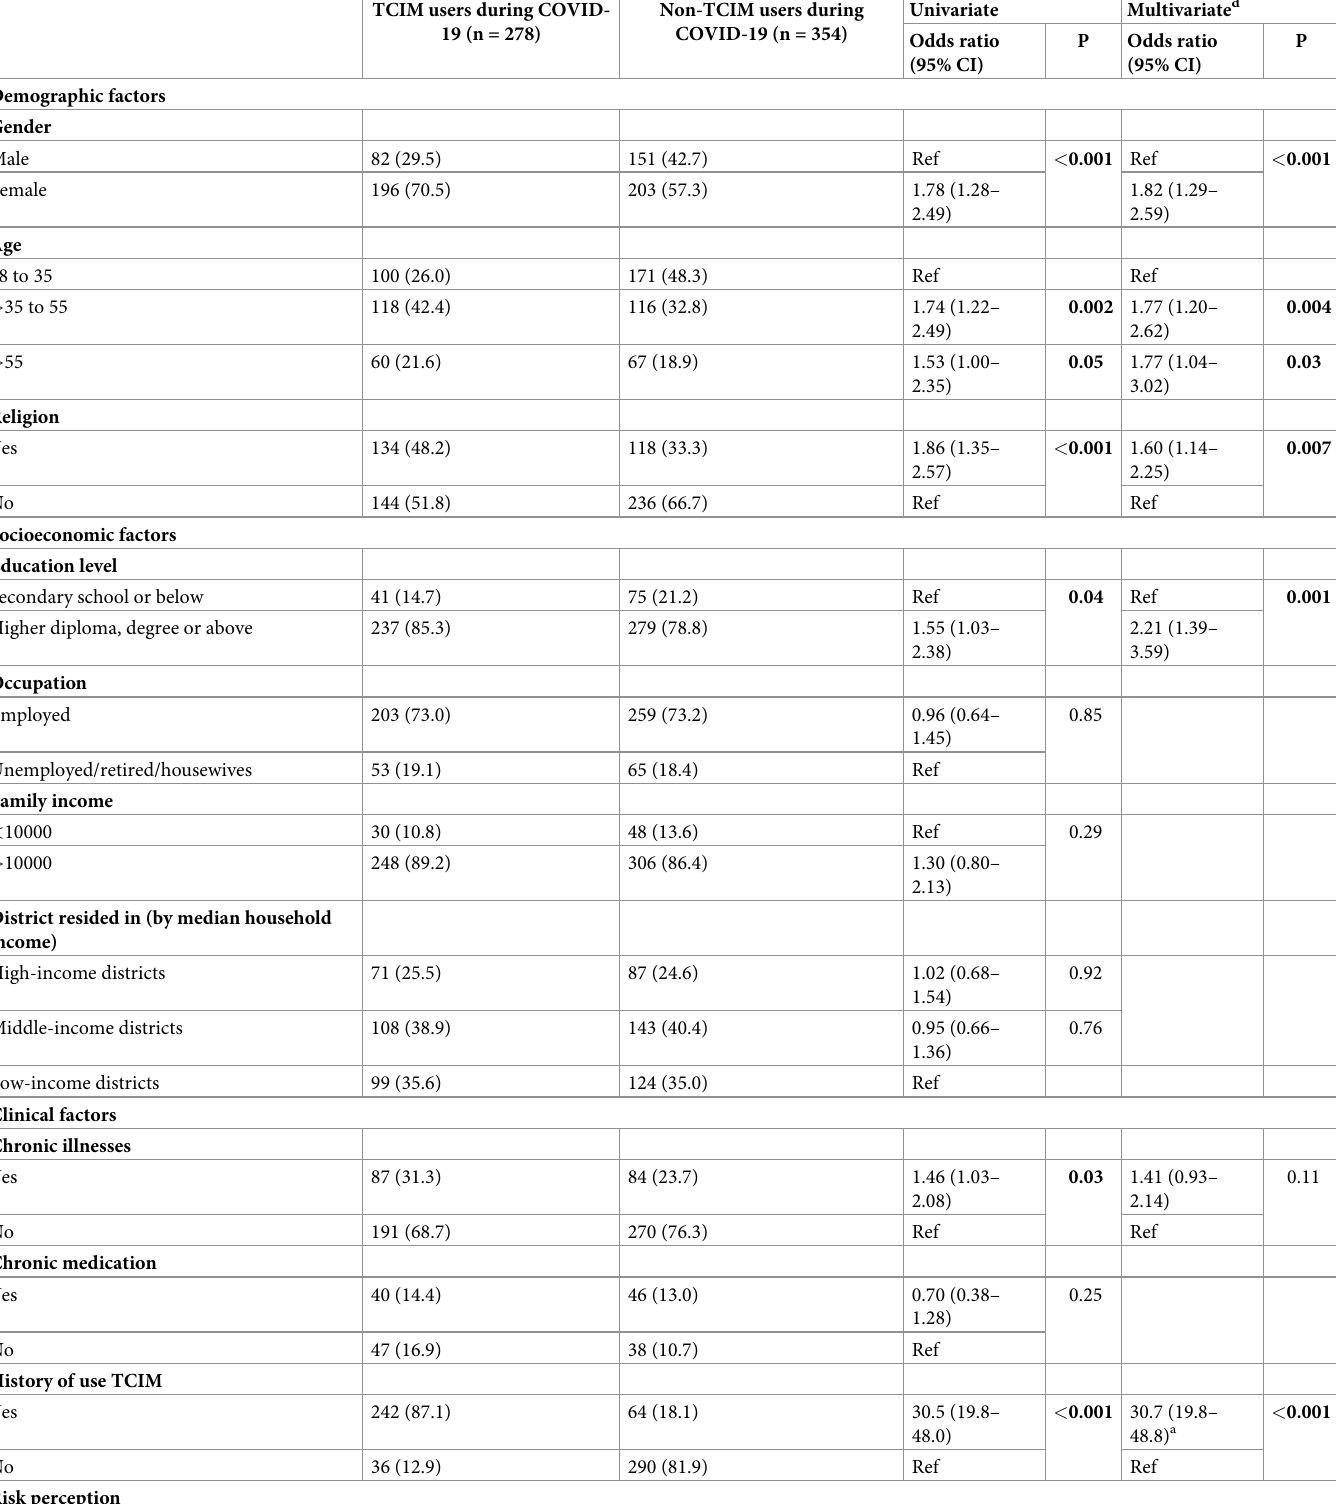
Table 3. Factors associated with use of TCIM during COVID-19 using logistic regression (n =